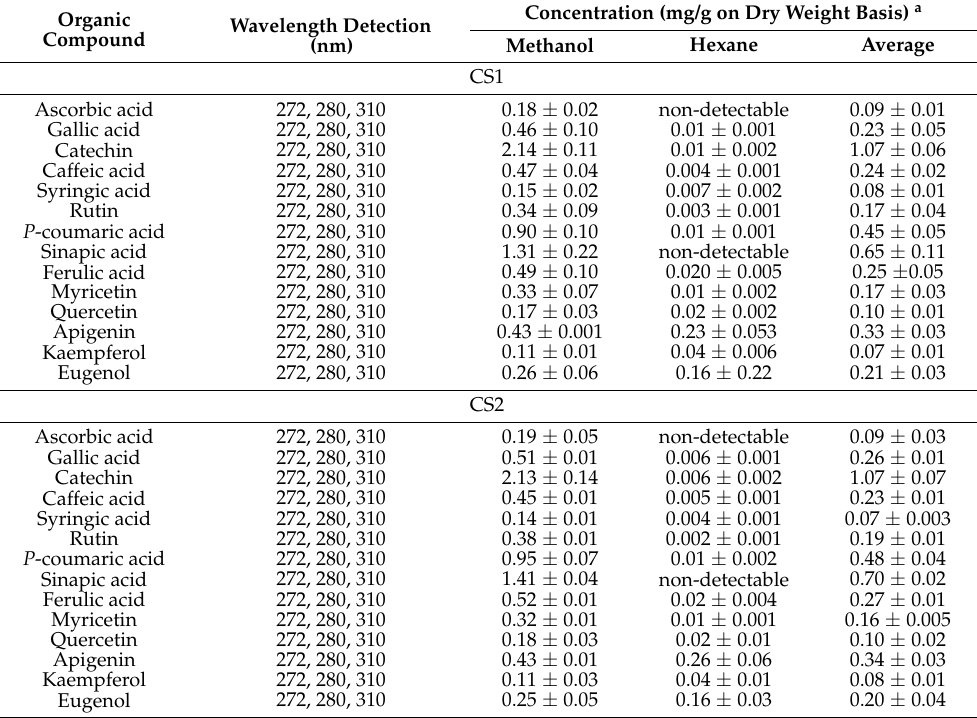
Table 1. Identifying and quantifying selected phytochemistry in methanolic and hexanoic extracts of Farang ( P. guajava L.) leaves harvested from various cultivation sites.